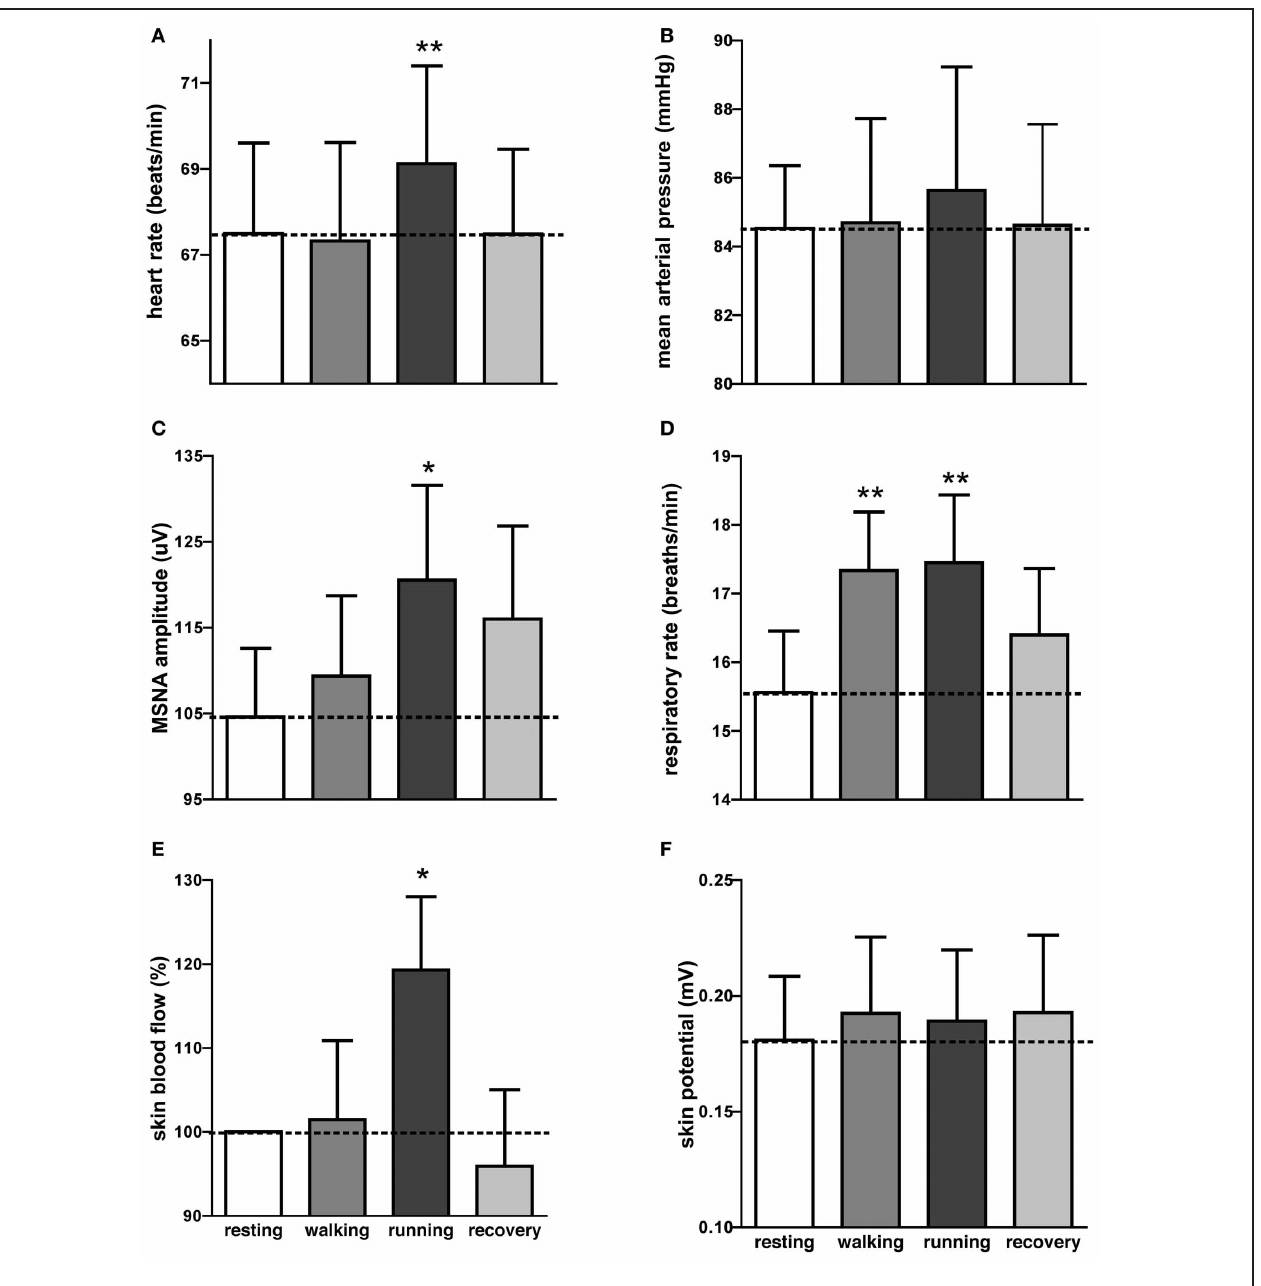
FIGURE 2 | Mean ( ± SE) values of heart rate (A), mean arterial pressure (B), MSNA burst amplitude (C), respiratory rate (D), skin blood flow (E), and sweat release (F) at rest, during